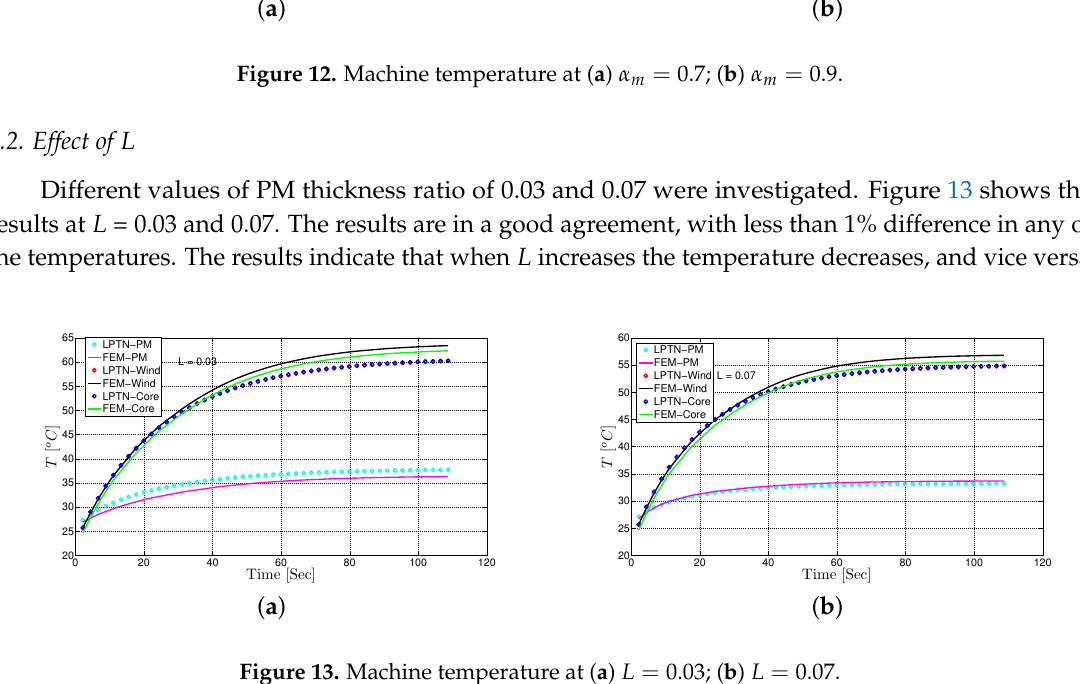
Figure 13. Machine temperature at ( a ) L = 0.03; ( b ) L =